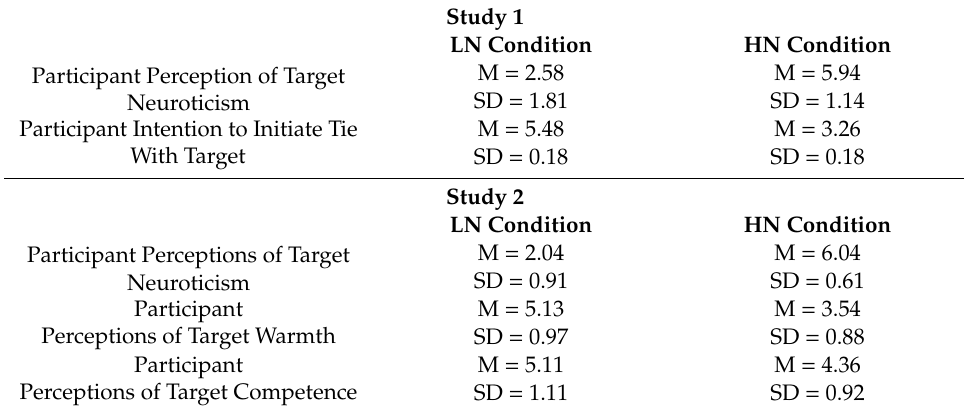
Table 1. Summary of Study 1 and Study 2 means and standard